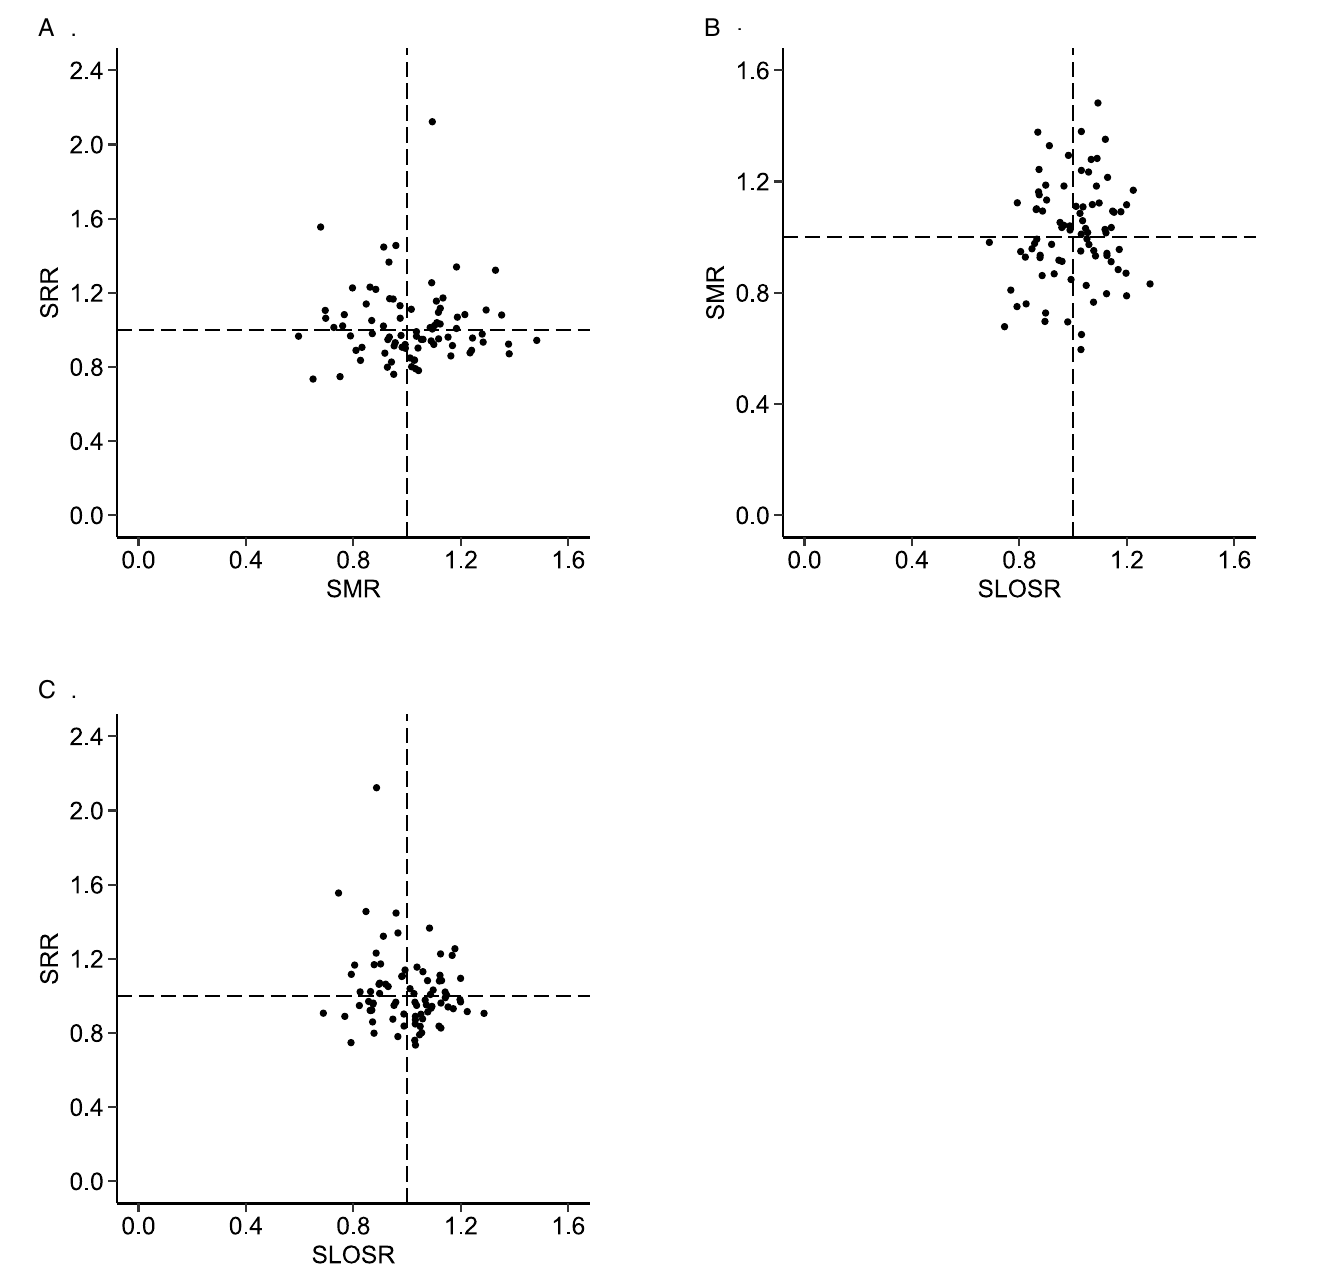
PLOS ONE | https://doi.org/10.1371/journal.pone.0198522 June 13,